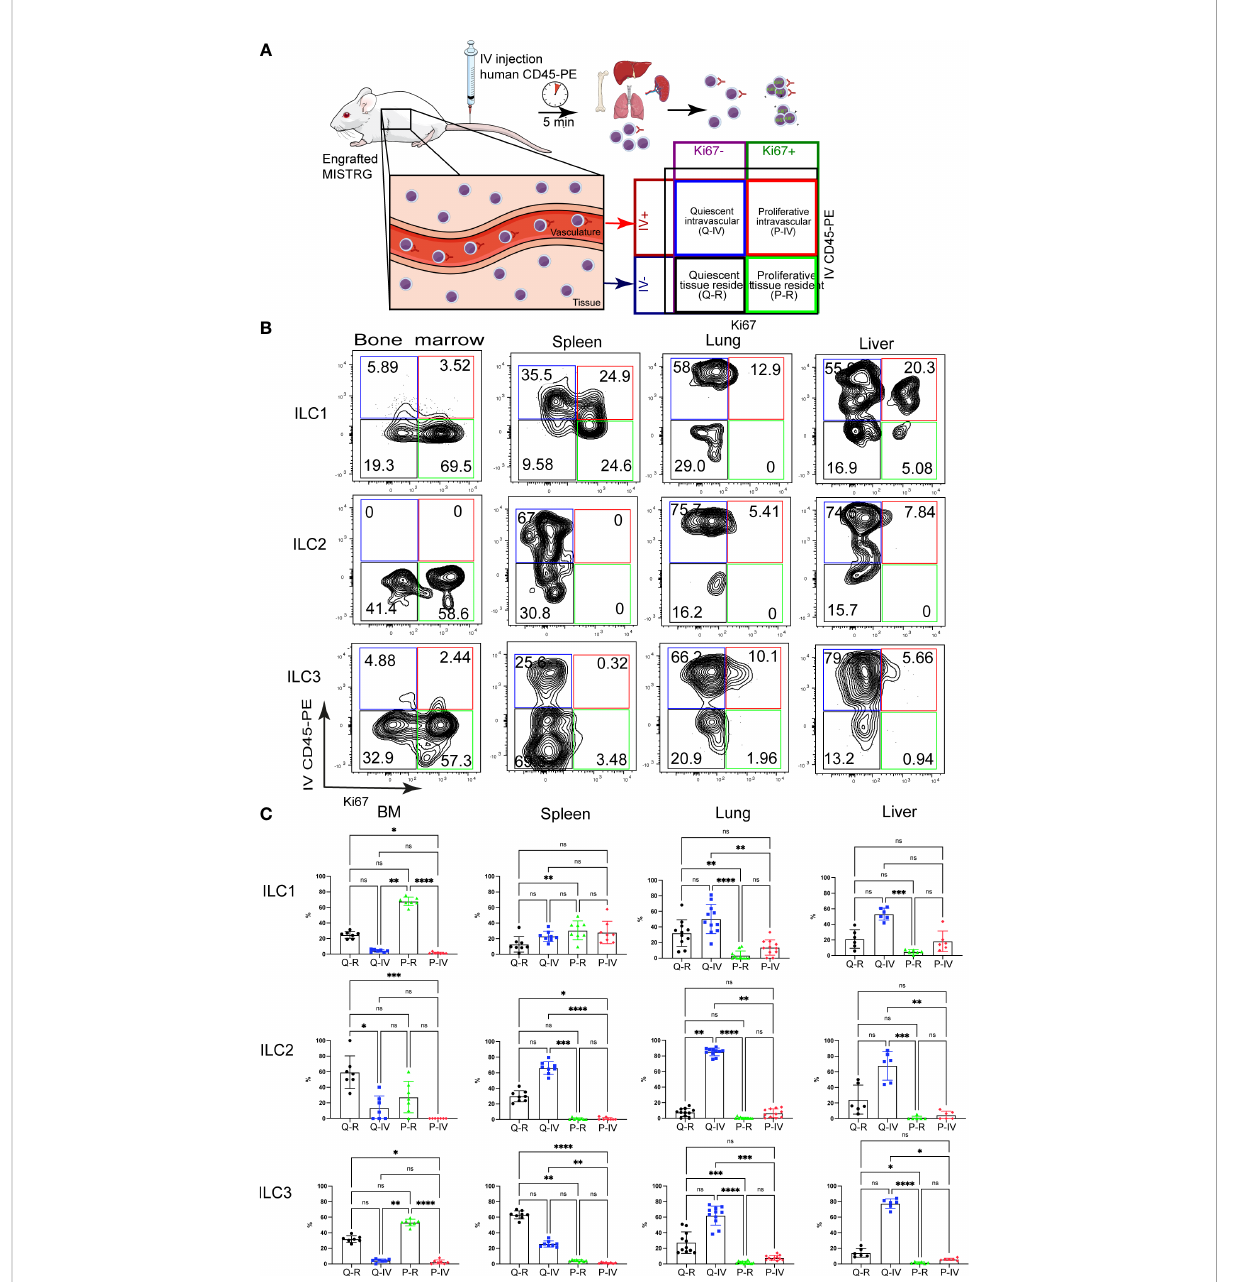
FIGURE 2 Spatial distribution of quiescent and proliferative ILCs within vascular and tissue compartments. (A) Experimental outline. Intracellular Ki67 staining of human ILCs was performed in HSPC-engrafted MISTRG mice after (IV) injection of anti-human CD45-PE antibody to label intravascular human hematopoietic cells. Human cells in the organ vasculature are stained by the IV-injected anti-CD45 antibody (IV CD45-PE), whereas cells residing in the tissue are not stained. Following intravascular labeling, cells were surface-stained ex vivo and stained intracellularly with an antibody against Ki67. Then quiescent (Ki67 - ) and proliferative (Ki67 + ) as well as intravascular (IVCD45-PE + ) and extravascular ILCs within tissue (IVCD45-PE - ) were distinguished by fl ow cytometry. (B) Flow cytometry analysis of intravascular versus extravascular and quiescent versus proliferative CD117 - CRTH2 - ILC1s, CRTH2 + ILC2s, and CD117 + ILC3s in the indicated organs of HSPC-engrafted MISTRG mice. ILCs were gated as human CD45 + CD127 + CD94 - CD3 - TCR ab - Lin - cells as in Supplementary Figure 1 and as CD34 - cells. (C) Frequencies of quiescent tissue- resident (Q-R), quiescent intravascular (Q-IV), proliferative tissue-resident (P-R), and proliferative intravascular (P-IV) human ILC1s, ILC2s, and ILC3s in the indicated organs (n = 6-11) as determined in (B). n.s., not signi fi cant; *, P <0.05; **, P < 0.01; ***, P <0.001; ****, P < 0.0001 by one-way ANOVA, Tukey ’ s post-test. Data represent mean ± SEM and are representative of two independent experiments using MISTRG mice engrafted with different pools of HSPCs. (A) was created with Mind the